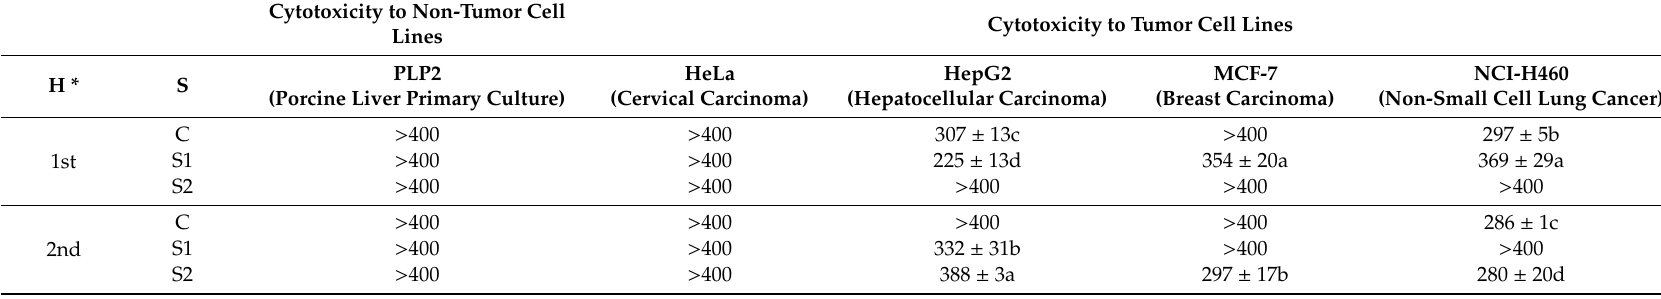
Table 10. Cytotoxicity and antitumor activity (GI 50 values µ g / mL) of Centaurea raphanina subsp. mixta leaves’ hydroethanolic extracts in relation to harvesting time and salinity level (mean ± SD, n =